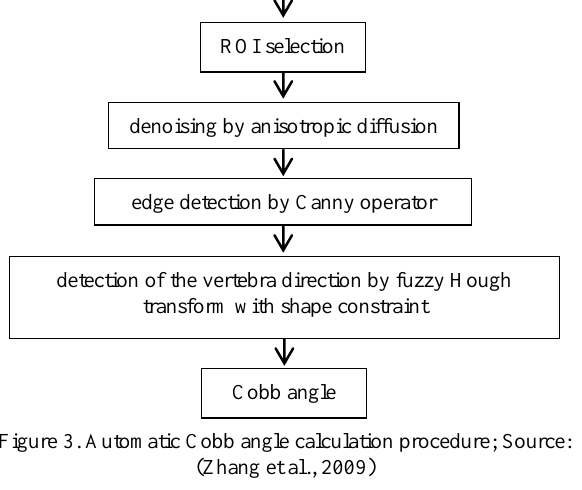
Figure 3. Automatic Cobb angle calculation procedure; Source: (Zhang et al., 2009)